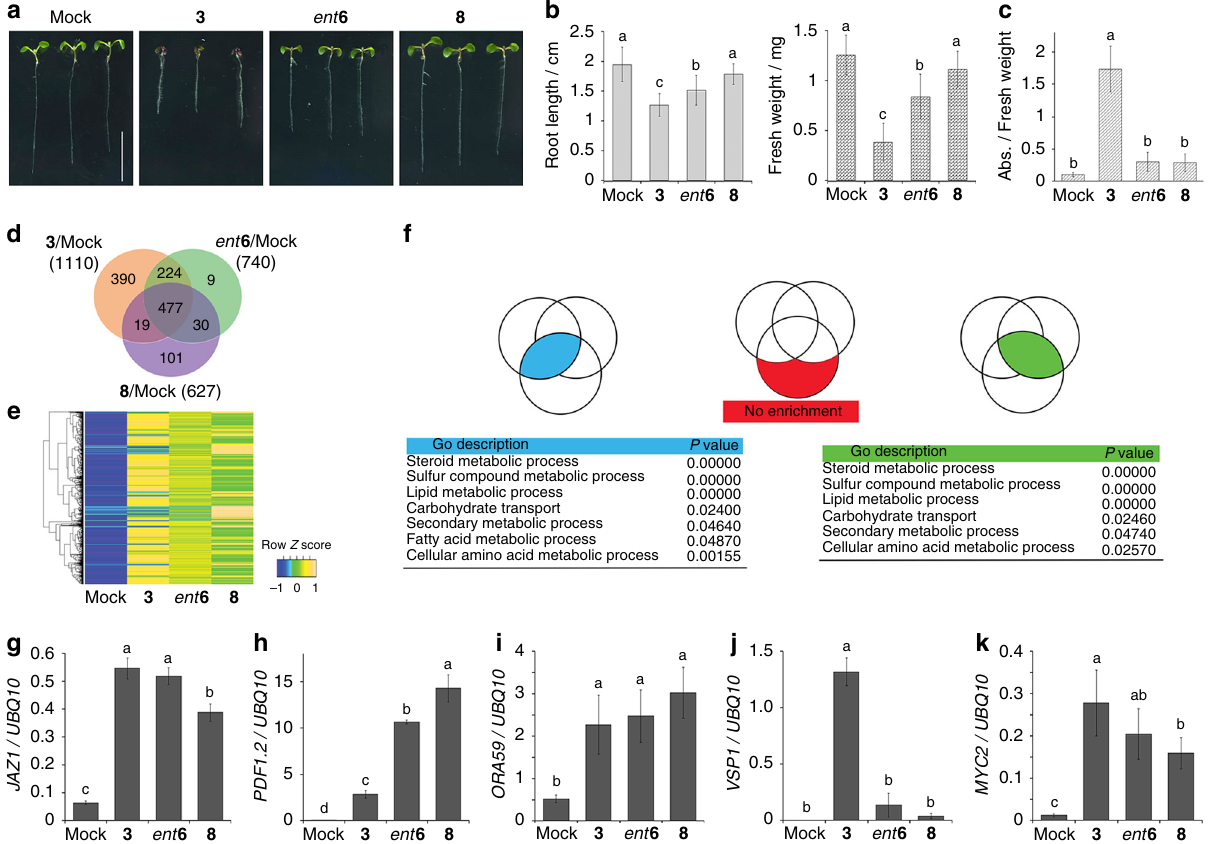
Fig. 4 JA responses and microarray analyses in 3 / ent 6 / 8 -treated Arabidopsis seedlings. a WT Arabidopsis seedlings grown for 6 days on 1/2 MS medium containing 3 , ent 6 , or 8 (1 µ M). Scale bar, 10 mm. b Quanti fi cation of root length or fresh weight of the aerial part in the ligand-treated seedlings shown in a ( n = 18). Signi fi cant differences were evaluated by one-way ANOVA/Tukey HSD post hoc test ( p < 0.01). c Quanti fi cation of accumulated anthocyanins in the ligand-treated seedlings shown in a . ( n = 15). Signi fi cant differences were evaluated by one-way ANOVA/Tukey HSD post hoc test ( p < 0.01). d Venn diagram indicating the number of genes up-regulated at least 2.5 times, in response to different treatments ( p < 0.05, FDR followed by Tukey ’ s HSD as post hoc test). e Heat map illustrating changes in gene expression in response to different treatments. Genes with at least a 2.5-fold increase in expression by 8 ( p < 0.05, FDR followed by Tukey ’ s HSD as post hoc test). f Go enrichment analysis of Fig. 4d. g – k Analysis of JA-responsive gene expression